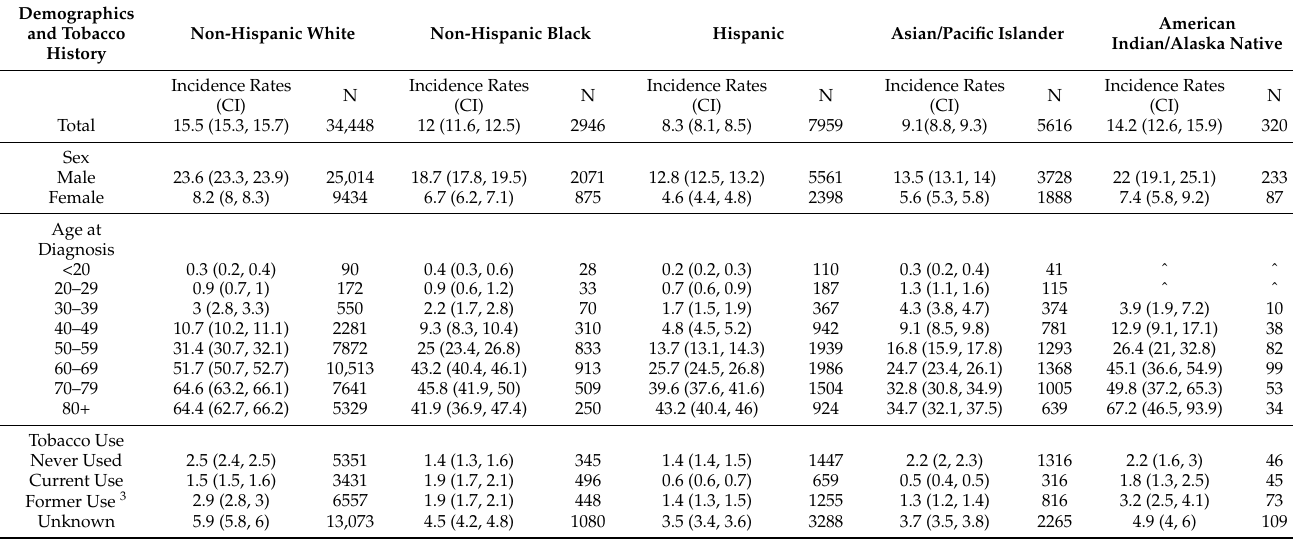
Table 1. Age-adjusted incidence rates 1 of head and neck cancers 2 , by race/ethnicity, sex, age at diagnosis, and tobacco use, 2009–2018